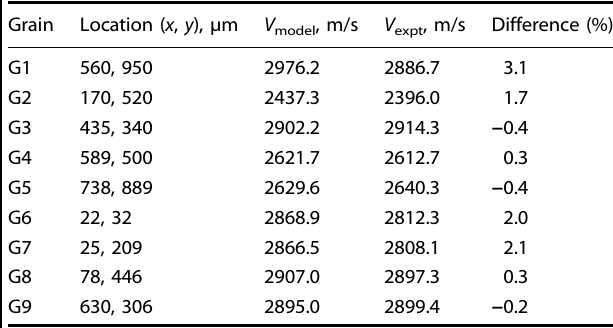
Table 1. Comparison of the SAW velocities between experiments and